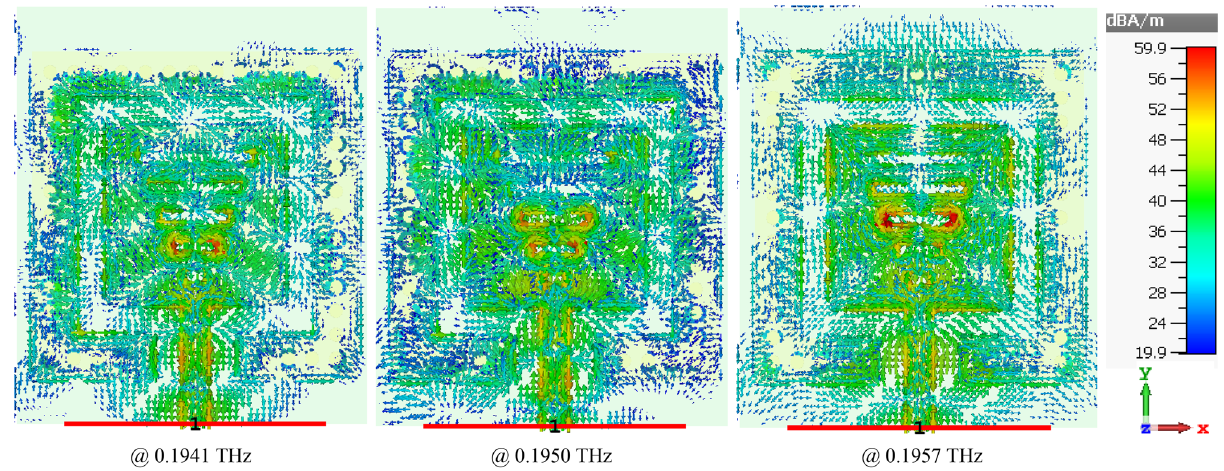
Figure 10. Surface current density distributions over the SIW-loaded MTM antenna at the first, second and third resonance